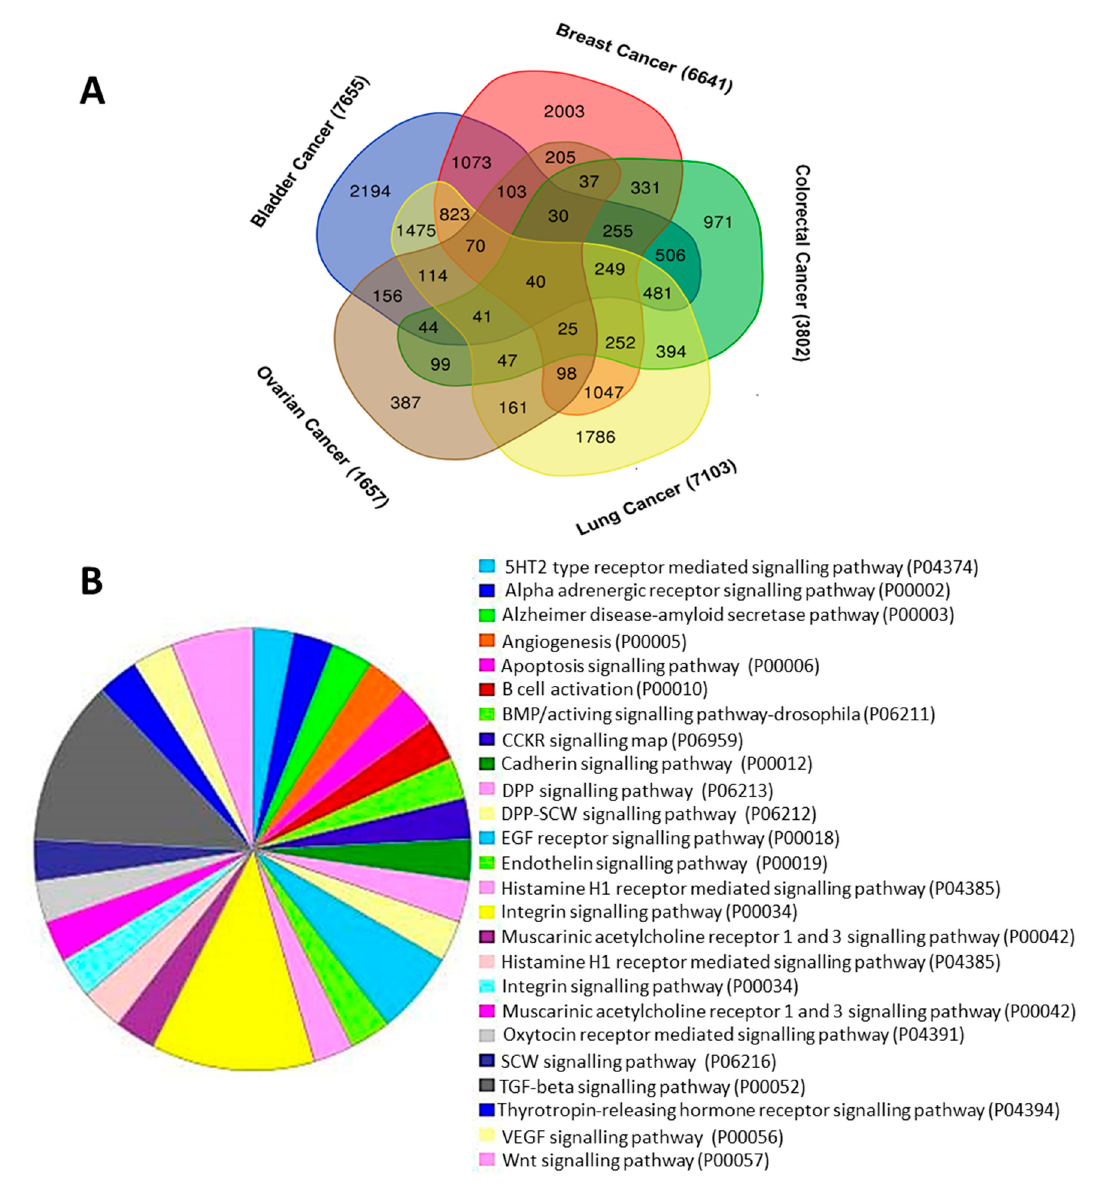
Figure 8. Analysis of genes that positively correlated with BMP5 and their pathways. ( A ) Analysis of positively correlated genes of BMP5 using the R2: Genomics Analysis and Visualization Platform. Venn diagram of genes positively correlated to BMP5 , showing coincident genes in breast, colorectal, lung, bladder, and ovarian cancers. ( B) Pathway analysis of BMP5 using PANTHER and subsequent classification based on their pathways; p < 0.05.